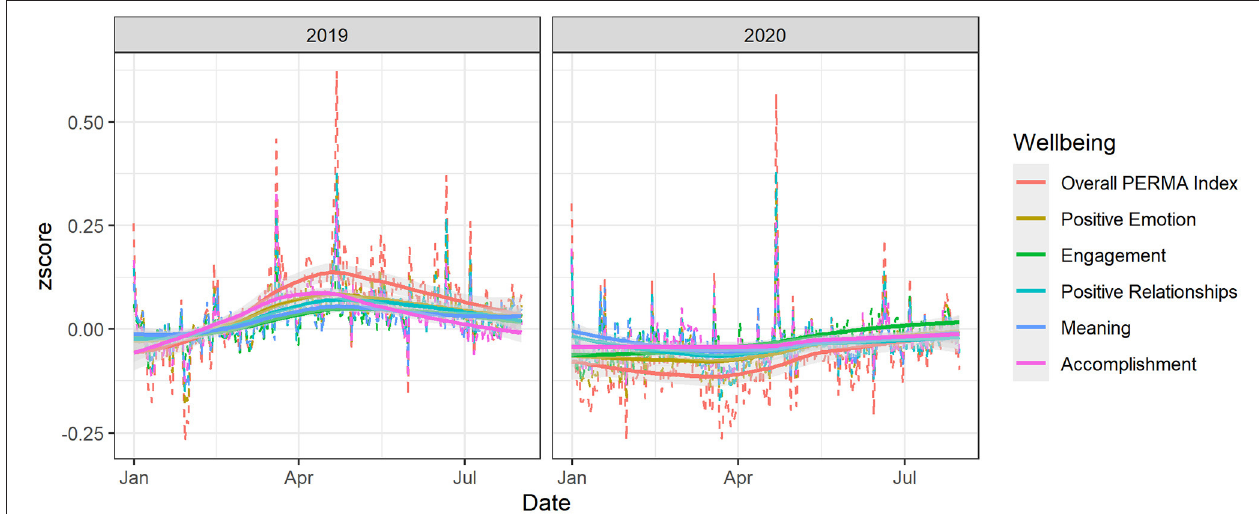
FIGURE 3 | Overall PERMA and individual subfactors during 2019 and 2020, as measured from Twitter dataset.